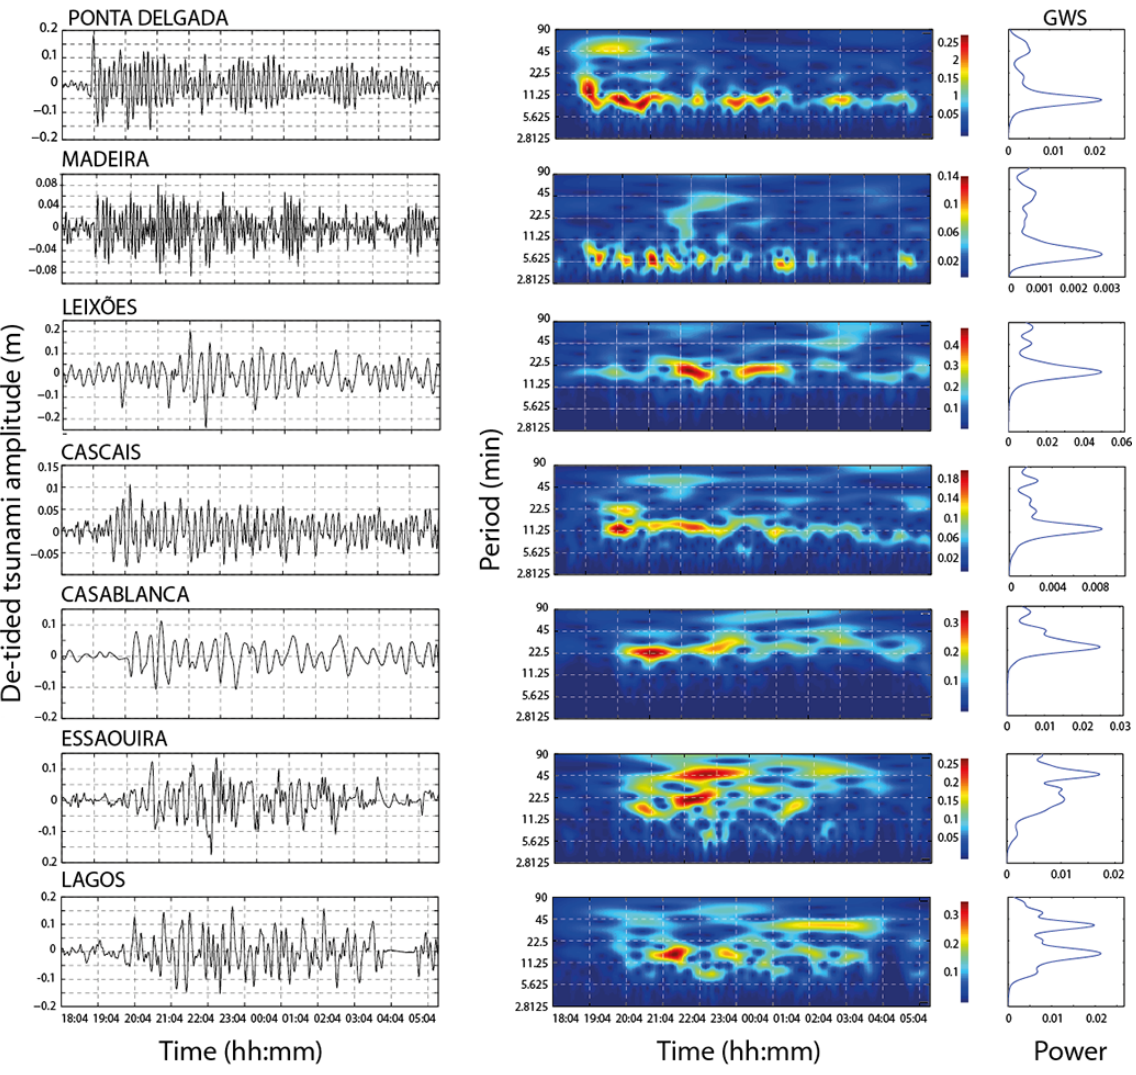
Figure 3. For each station: tsunami signals (de-tided and filtered record) (left panels), wavelet amplitude spectrum (middle panels) and global wavelet spectrum (GWS) (right panels). The initial time, 18:04UTC, is the time of the